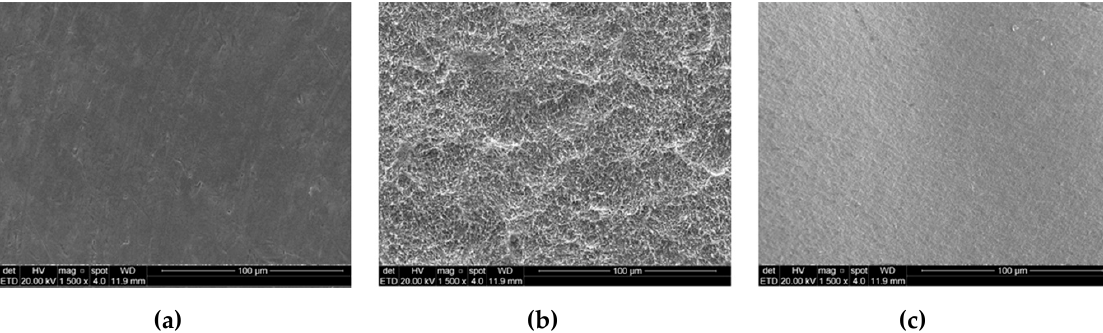
Figure 1. Scanning Electronic Microscopy images of the implant surface of ( a ): TiM group, ( b ): TiT group and ( c ): Zr group, respectively. The increase of 1.500×.